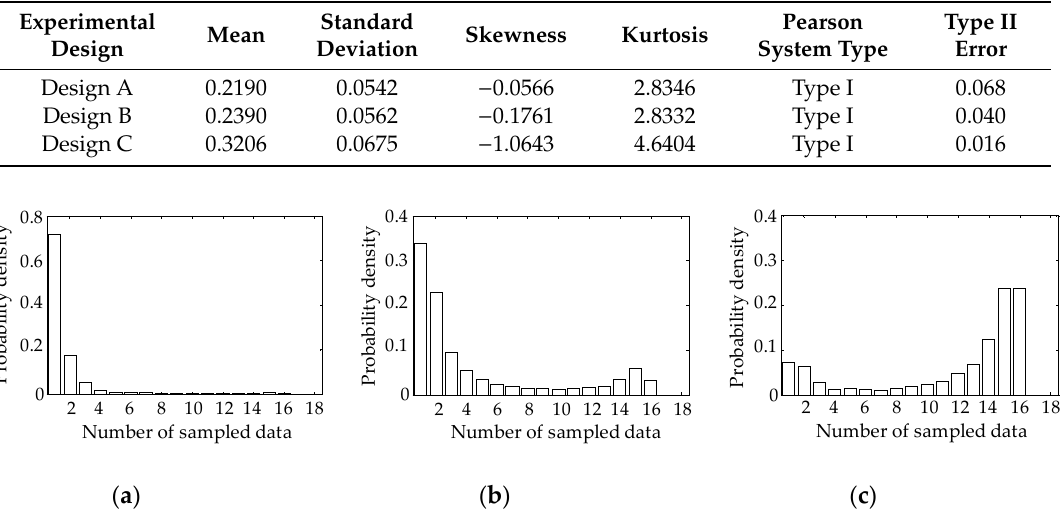
Figure 8. PDF of each area metric ( U ) for the three design conditions.